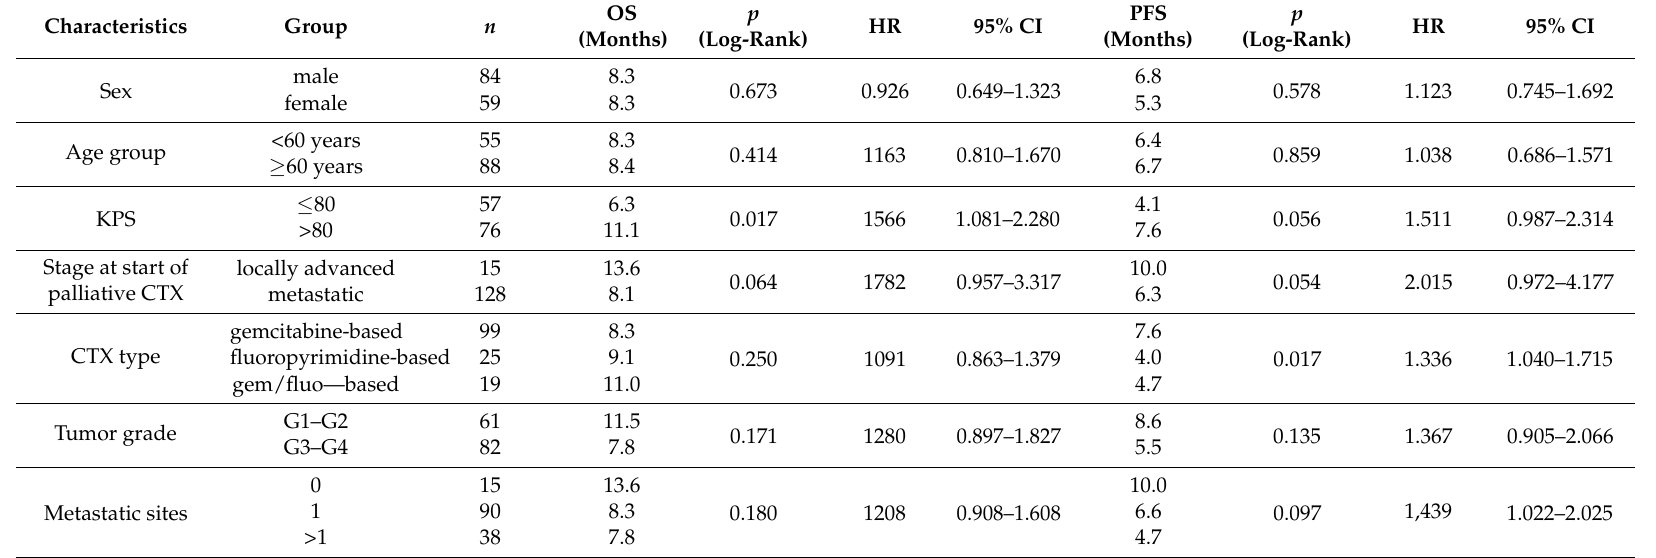
Table 1. Frequency of the patients’ clinicopathological characteristics (sex, age, Karnofsky performance status (KPS), disease stage at start of first-line chemotherapy, type of first-line chemotherapy (CTX), tumor grade and number of metastatic sites) and correlation to overall survival (OS) and progression-free survival (PFS) with corresponding hazard ratios (HR) and confidence intervals